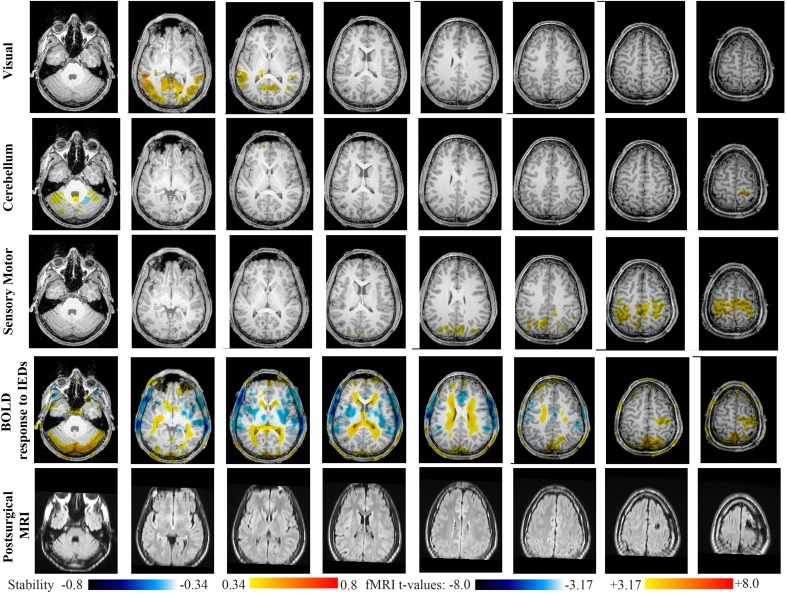
Evaluation of DANI on Patient 6 with right frontal FCD. Results are presenting most salient stability changes observed in Cmapn followed by a t-map of the BOLD response to epileptic discharges and a postsurgical FLAIR MRI, all resampled in the native anatomical MRI space of the patient. Most salient stability changes observed for Cmapn of Visual, Cerebellum, and Sensory Motor networks are presented. The Visual and Cerebellum networks were also involved in significant interactions of modularity changes at p < 0.001. Same colormap conventions than in Figure 6.